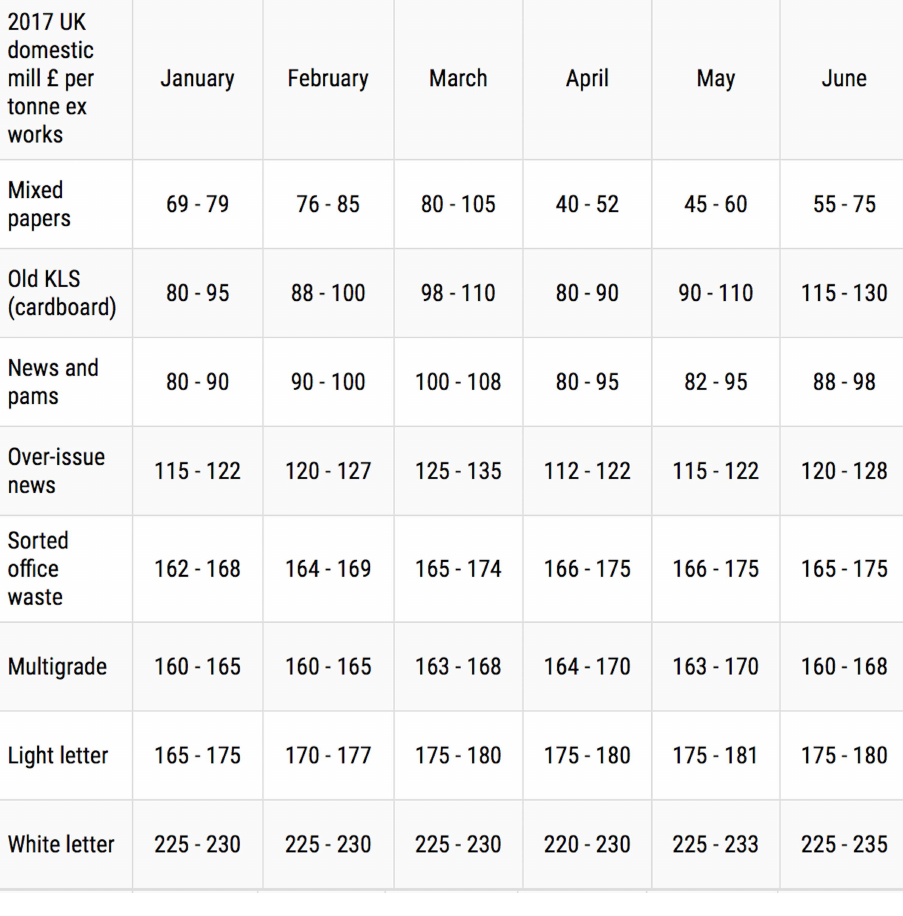
Figure 3. Waste paper prices for the fi rst half of 2017. Source: https://www.letsrecycle.com/prices/waste-paper/, accessed May 5,